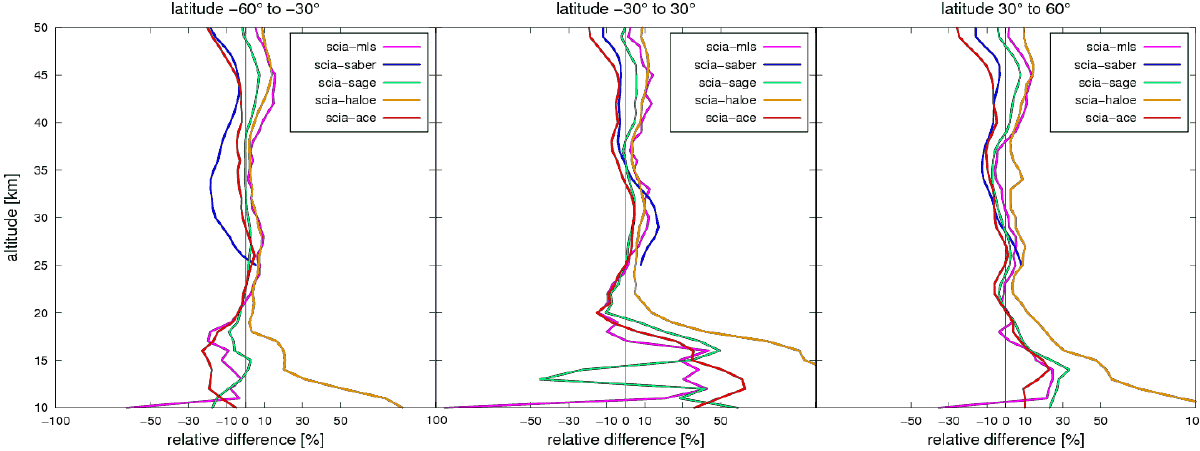
Fig. 5. Same as Fig. 4 but for zonal means only derived from collocated profiles.